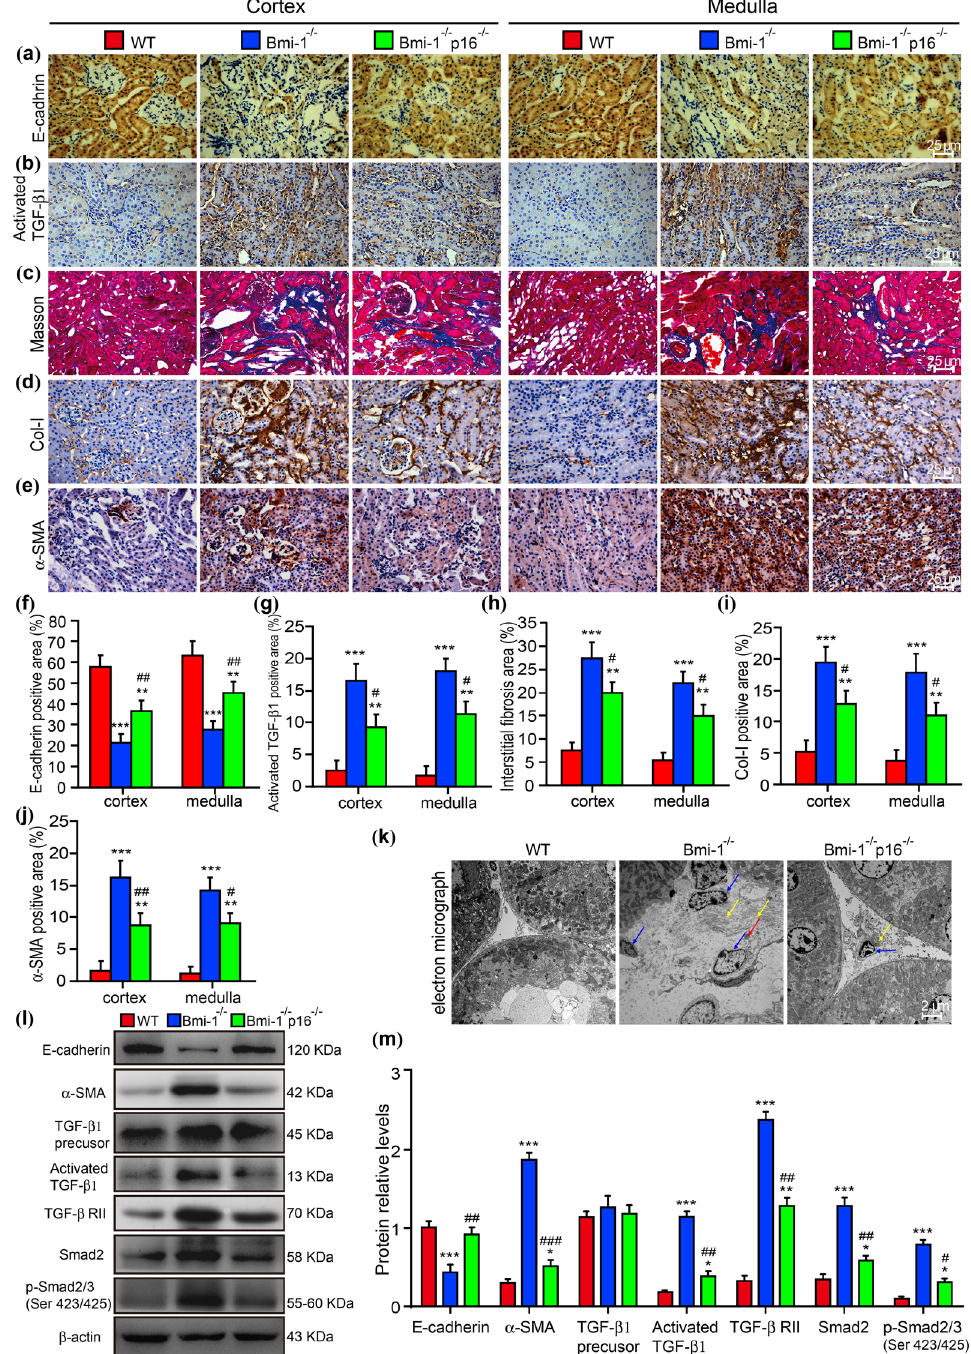
Figure 4. P16 deletion improved senescence-associated pro-fibrotic secretory phenotype and tubulointerstitial injury in Bmi - 1 − / − mice. Representative micrographs of paraffin-embedded kidney sections stained immunohistochemically for ( a ) E-cadherin and ( b ) activated transforming growth factor- β 1 (TGF- β 1); histochemically for ( c ) Masson’s trichrome (Masson), and immunohistochemically for ( d ) type Ι collagen (Col- I) and ( e ) α -smooth muscle actin ( α -SMA). Percentage of ( f ) E-cadherin positive area, ( g ) activated TGF- β 1 positive area, ( h ) interstitial fiber positive area demonstrated by Masson’s trichrome stain, ( i ) Col-I positive area and ( j ) α -SMA positive area. ( k ) Electron micrograph of kidney sections from Bmi - 1 − / − , Bmi - 1 − / − p16 − / − and WT mice. Blue arrows: fibroblasts; yellow arrows: collagen fibrils; red arrows: hemorrhage in renal tubulointerstitium. ( l ) Western blots of kidney extracts for E-cadherin, TGF- β 1, α -SMA, TGF- β 1 precursor, activated TGF- β 1, transforming growth factor- β receptor II (TGF- β RII), Smad2 and pSmad2/3 (Ser423/425). β -actin was the loading control. ( m ) Protein relative to β -actin was assessed by densitometric analysis. Six mice per group were used for these experiments. Values are mean ± SEM from six determinations per group. * P < 0.05, ** P < 0.01, *** P < 0.001 compared with WT group; # P < 0.05, ## P < 0.01, ### P < 0.001 compared with Bmi - 1 − / −